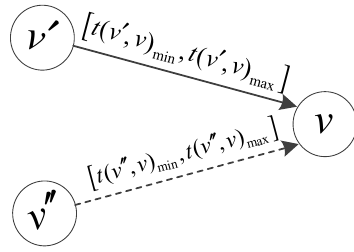
Figure 1. Diagram of OR causality relationship.